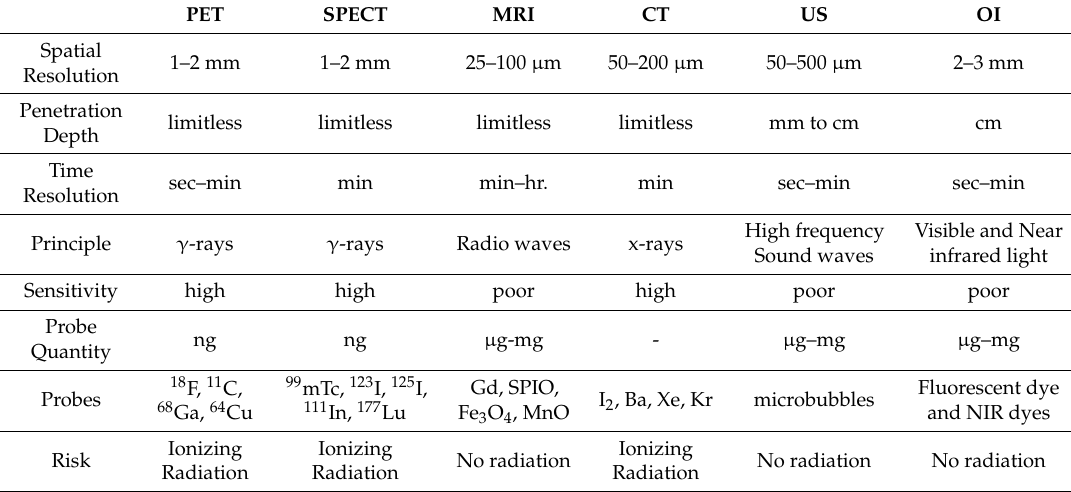
Table 1. A comparison of various imaging modalities available for clinical imaging purposes. PET SPECT MRI CT US